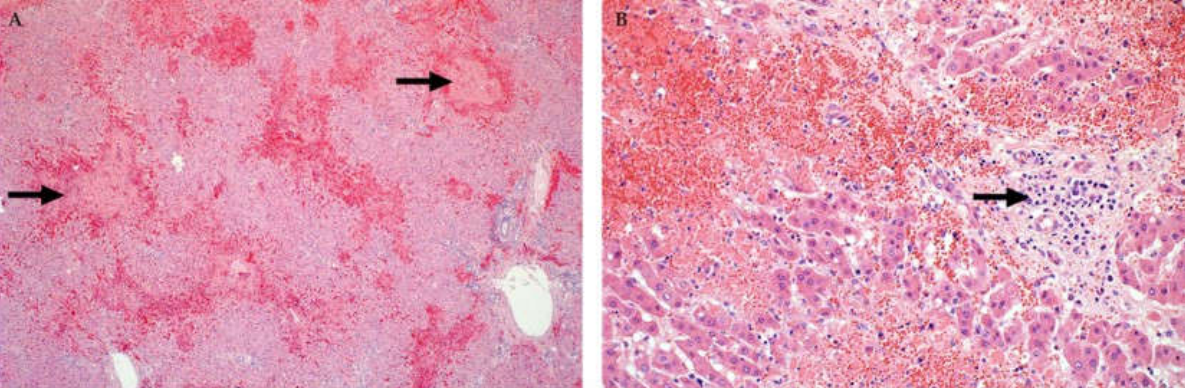
Figure 2. Histopathology of the liver of cattle naturally infected with RVFV (Haematoxylin and eosin (H&E) stain). ( A ) Random multifocal to coalescing necrosis and haemorrhage (arrows), original magnification (mag) 40×. ( B ) Necrosis of hepatocytes extends into the periportal zones, specifically affecting hepatocytes of the limiting plate. Mild mononuclear cell inflammation (arrow) is also present in the portal area, mag 200×.